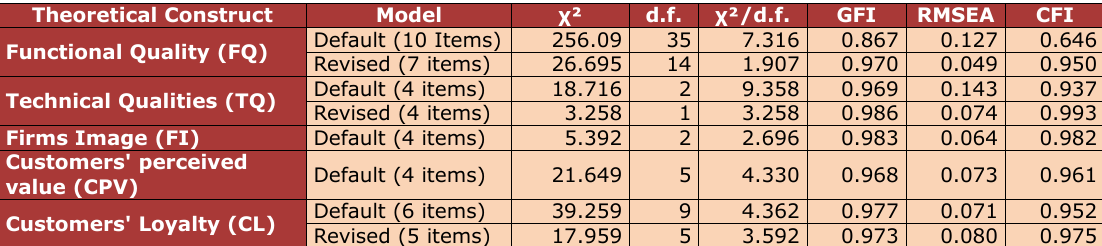
Table 3. Level of acceptance of the unidimensional